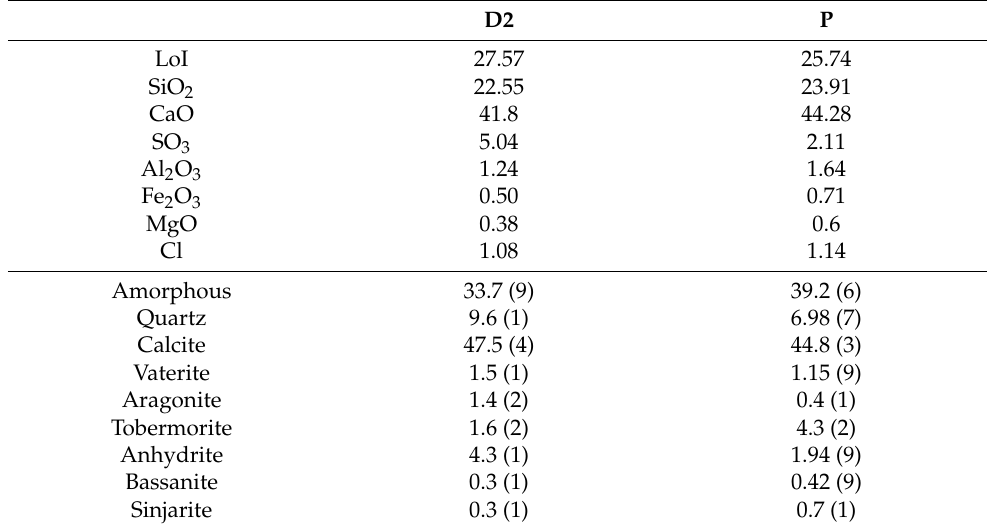
Table 1. Chemical composition and quantitative phase contents (XRD and Rietveld refinement) of the raw materials in wt%. Loss of Ignition = LoI. Additional contents of TiO 2 , Na 2 O, and K 2 O < 0.4 wt%. E.s.d.s of the Rietveld refinements are shown in parentheses. The samples contain additionally <1 wt%